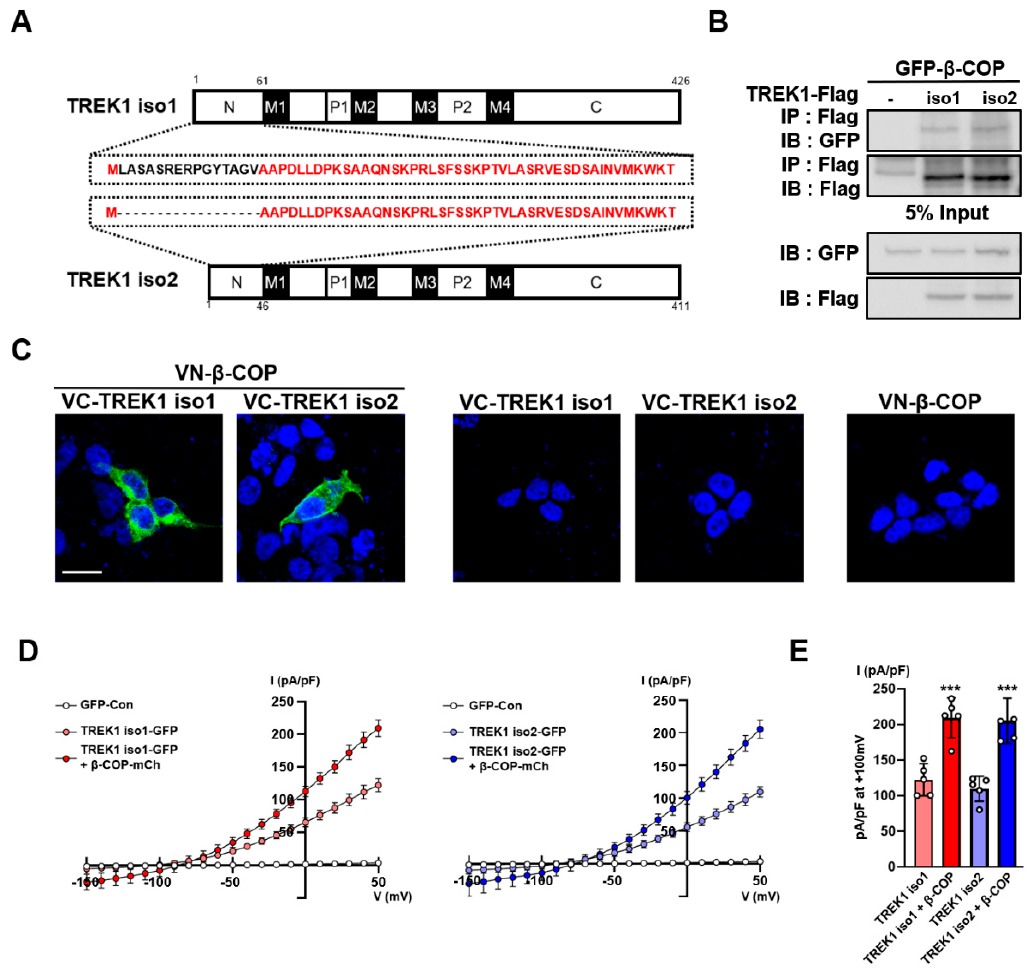
Figure 2. β -COP interacts with TREK1 isoforms. ( A ) Schematic of full-length TREK1 isoforms, TREK1 isotype 1 (up), TREK1 isotype 2 (down), and identical amino acids are marked in red. ( B ) Co-IP in HET293T cell. After transfection of Flag-tagged isoforms of TREK1 and GFP- β -COP, immunoprecipitation with Flag was performed and blotted with GFP. ( C ) The bimolecular fluorescence complementation (BiFC) assay in HET293T cells. Venus fluorescence was observed when VN- β -COP and VC-TREK1 isotype 1 or VC-TREK1 isotype 2 were co-transfected and was not when transfected alone. Scale bar, 20 µm. ( D ) Averaged current-voltage ( I - V ) relationship of GFP-Con transfected(white), TREK1 isotype 1 IRES2 GFP transfected (light red), TREK1 isotype 1 IRES2 GFP and β -COP IRES2 mCherry co-transfected (red) astrocytes (left), GFP-Con transfected (white), TREK1 isotype 2 IRES2 GFP transfected (light blue), TREK1 isotype 2 IRES2 GFP, and β -COP IRES2 mCherry co-transfected (blue) astrocytes (right). ( E ) Bar graph indicated TREK1-mediated currents averaged from results in ( D ) at +50 mV. All values are expressed as the mean ± SEM. SEM, standard error of the mean. p -values were obtained with Student’s t -test. *** p < 0.001.